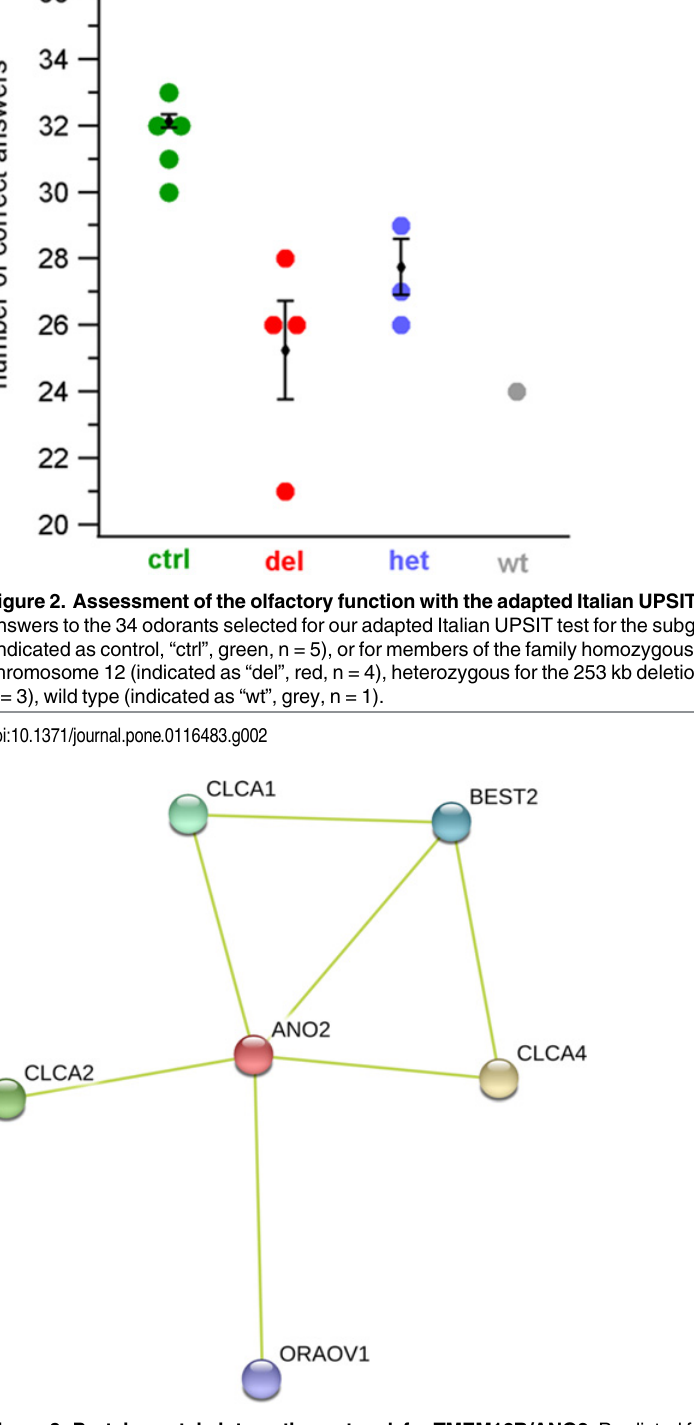
Figure 3. Protein-protein interaction network for TMEM16B/ANO2. Predicted functional partners obtained with the database STRING v9.01